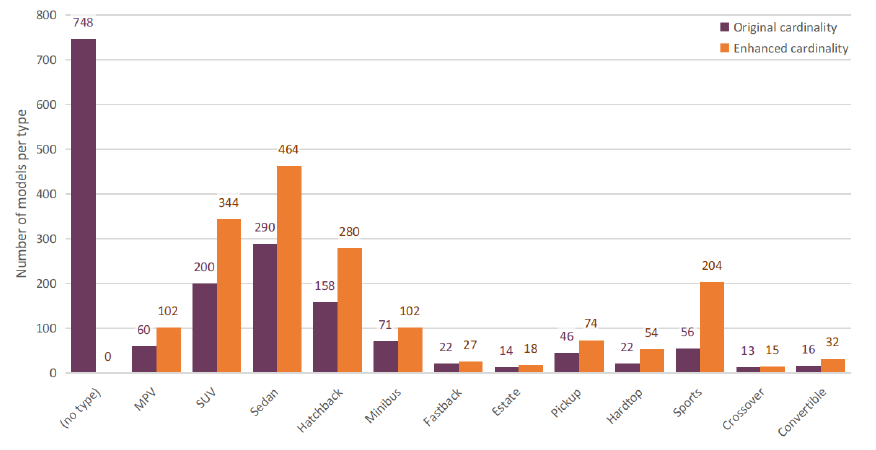
Figure 3. Distribution of the car type classes. Each column represents the number of car model classes belonging to a certain car type (different years are merged into one model for this representation). Dark bars refer to the original CompCars dataset, orange bars refer to the dataset revisited with our label